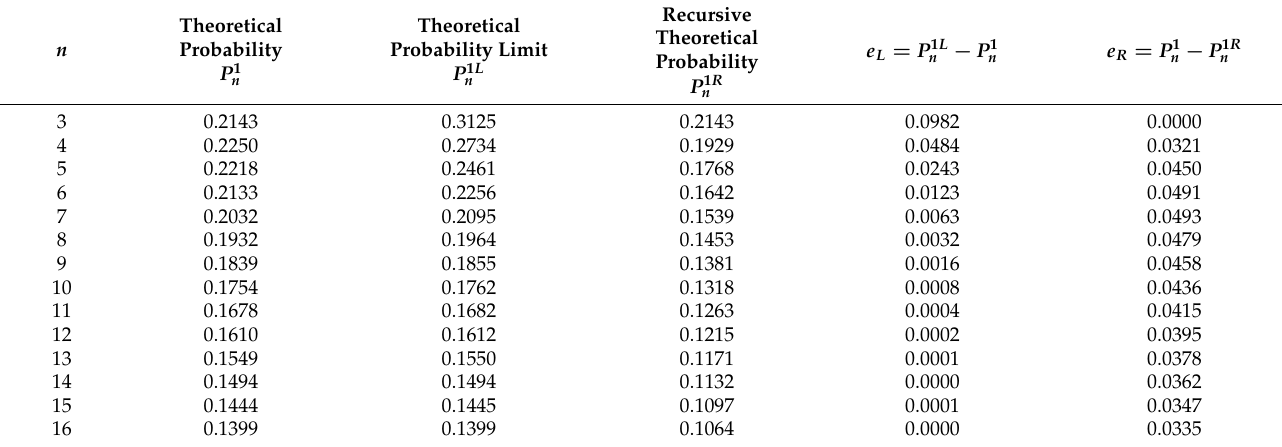
Table 3. Comparing the probabilities limits P 1 L n and P 1 R n recursive probabilities with exact theoretical probabilities P 1 n .